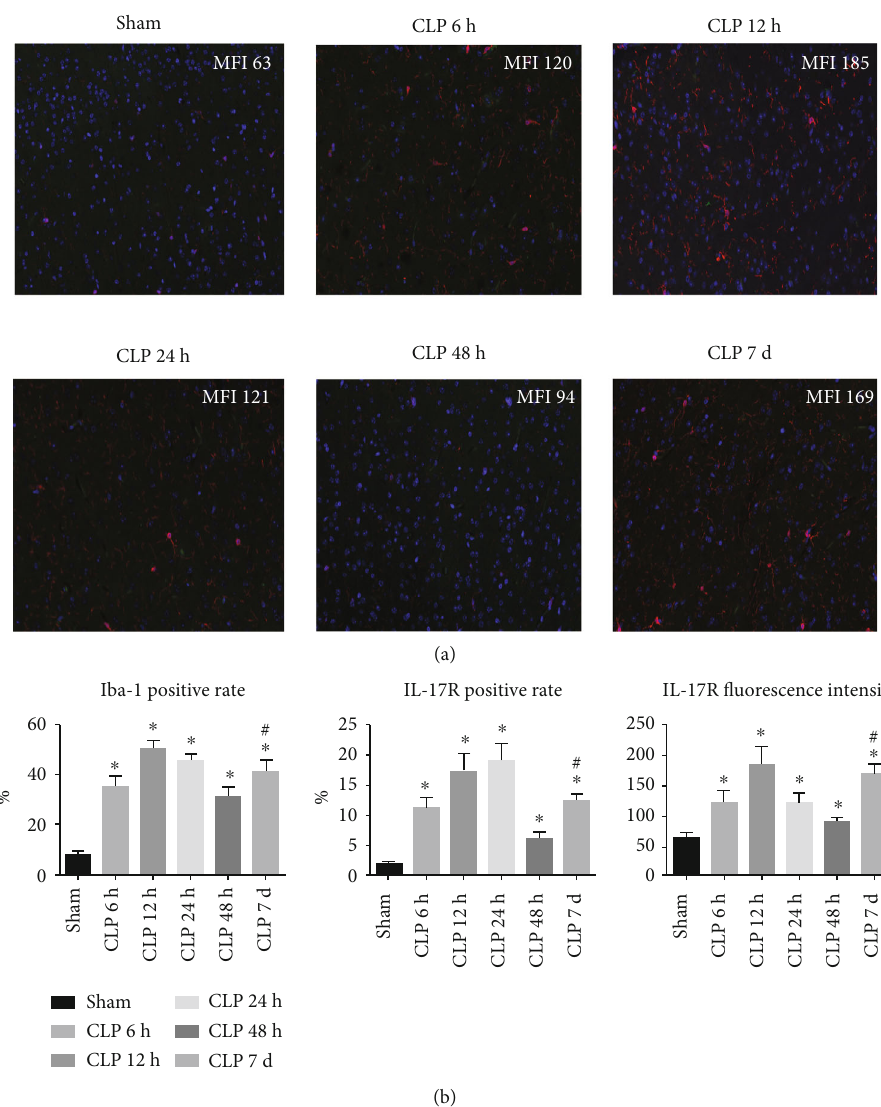
Figure 3: IL-17R expression in the hippocampus region was determined by IF at 6h, 12 h, 24 h, 48 h, and day 7 post surgery. (a) Representative image of the IF assay in the hippocampus. Specimens were stained with IL-17R (green), Iba-1 (red), and DAPI (blue). Representative images were merged and analyzed (1 : 200). Mean fl uorescence intensity (MFI) of IL-17R was shown in each image. (b) Summary data of IL-17R and Iba-1 expression in the hippocampus region ( n = 5 ‐ 6 ). ∗ P < 0 : 05 vs. sham control; # P < 0 : 05 CLP day 7 vs. CLP 48